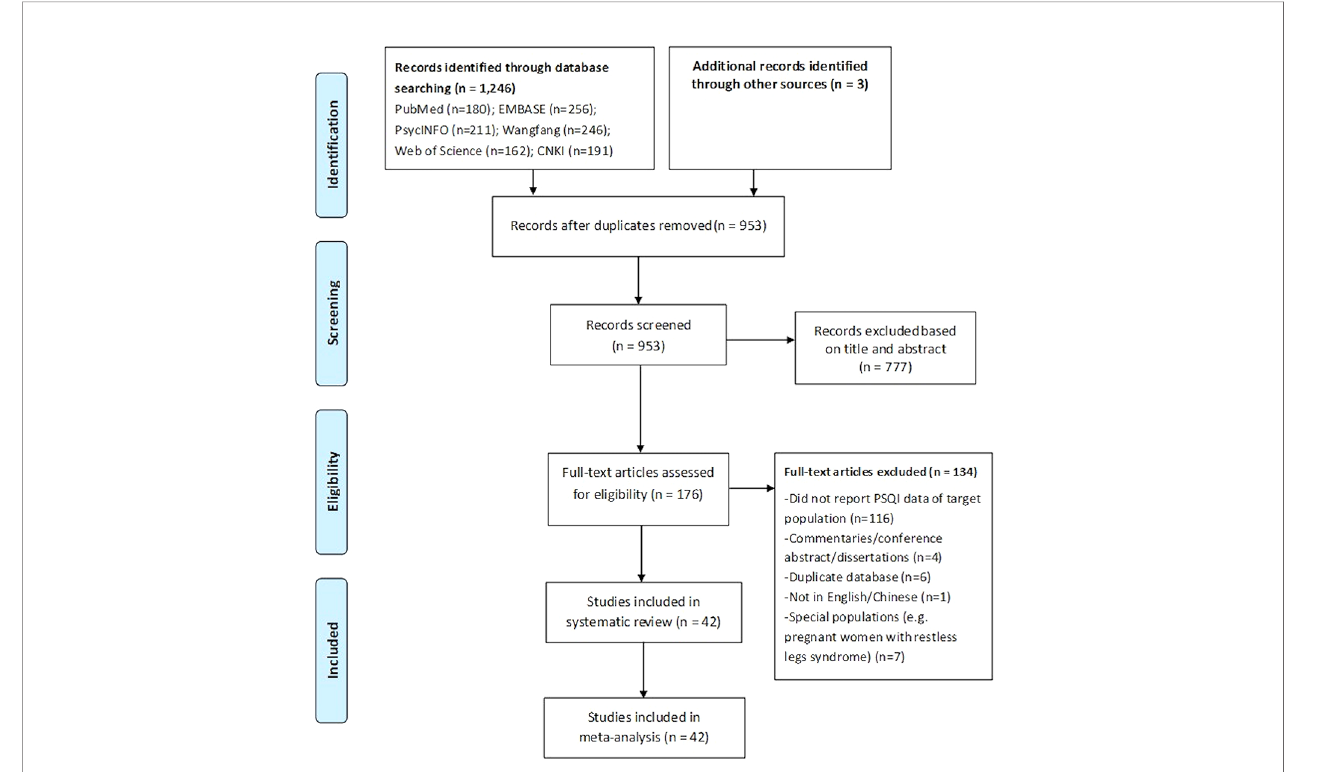
FIGURE 1 | PRISMA